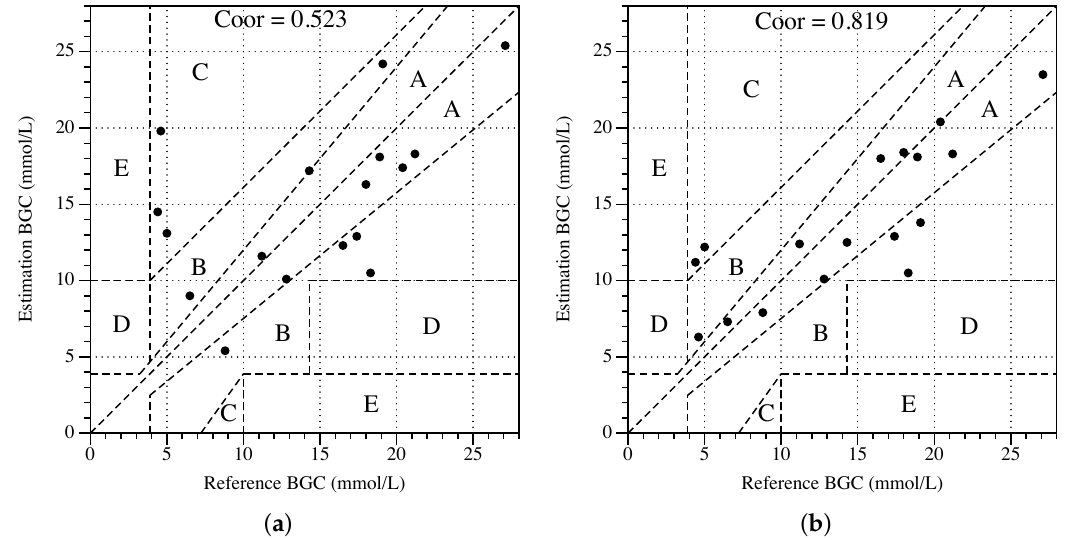
Figure 5. Clarke Error Grid Analysis for our proposed NGM system (( a ) is RF without ICA, and ( b ) is RF with ICA), in which the x-axis is the reference Blood Glucose Concentration (BGC) and the y-axis is the estimated BGC. In ( b ), 64.7% of points fall in region A, while in ( a ) there is only 47.1%.